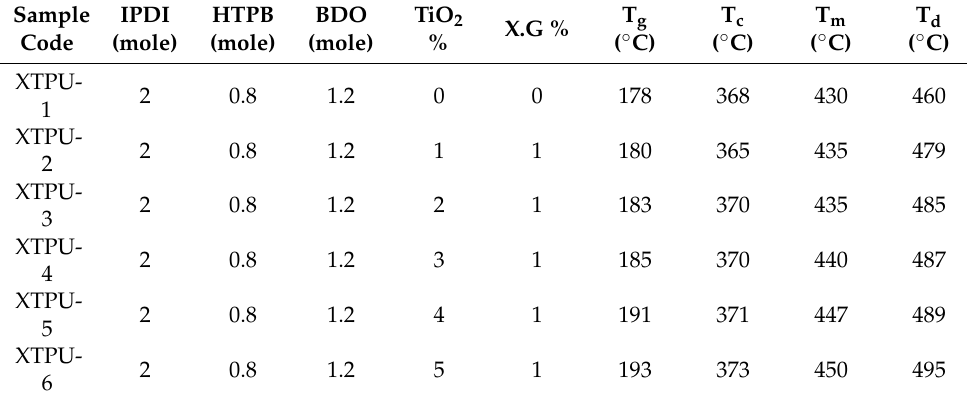
Table 3. Thermal stability data of the XTPU samples based on